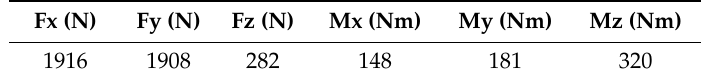
Table 2. Maximum forces and moments at the joints, computed through the multibody dynamic